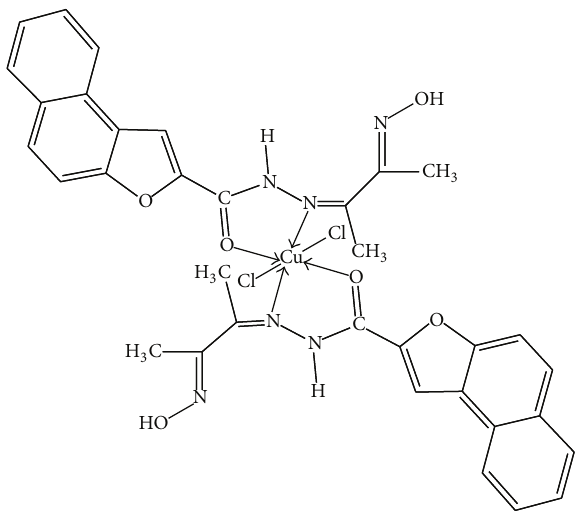
Figure 5: Suggested structure for [Cu(C 17 H 15 O 3 N 3 ) 2 Cl 2 ] complex.